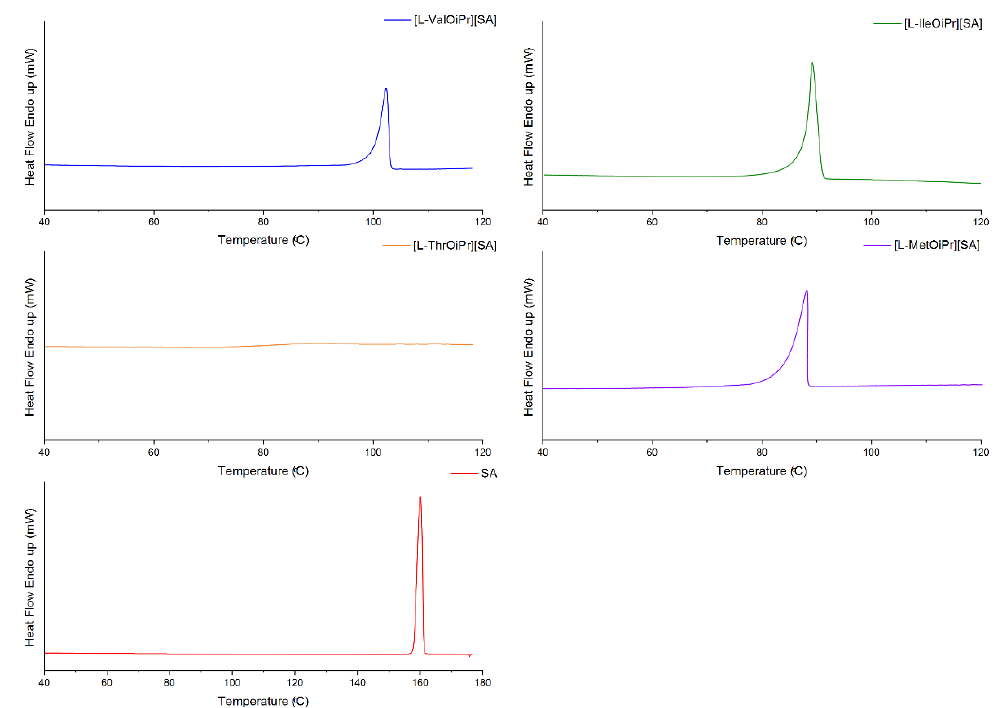
Figure 5. The DSC curves of first heating cycle of salicylic acid and salicylic acid salts: [L − ValOiPr][SA] (blue), [L − IleOiPr][SA] (green), [L − ThrOiPr][SA] (orange), [L − MetOiPr][SA] (purple), SA (red).